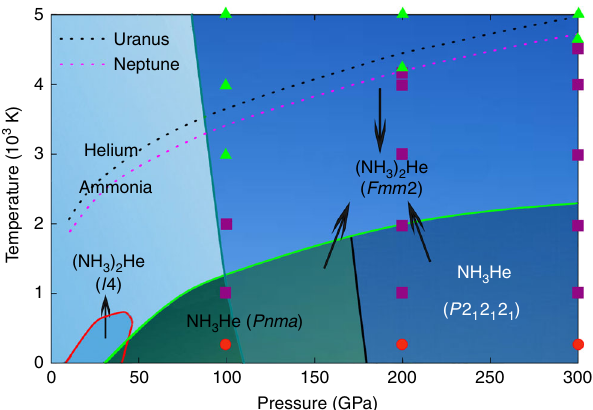
Fig. 5 Pressure – temperature phase diagram. Solid lines represent the stability fi eld of each composition. Dashed lines indicate planetary geotherms estimated for the interiors of Uranus (black) and Neptune (magenta) 45 . Molecular dynamic calculations are performed under different extreme conditions and the results are marked in the fi gure: The red circle, purple square, and green triangle represent solid phase, superionic phase and fl uid, respectively. Black arrows indicate the stable pressure – temperature regions associated with the arrowhead pointing